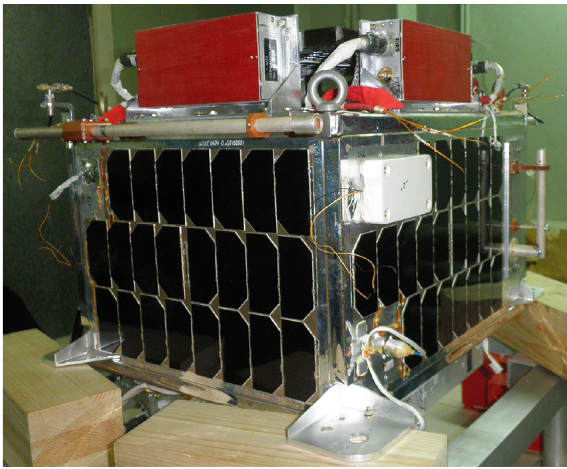
Figure 1. There is the small spacecraft prototype "Aist. (cited in 4 ).